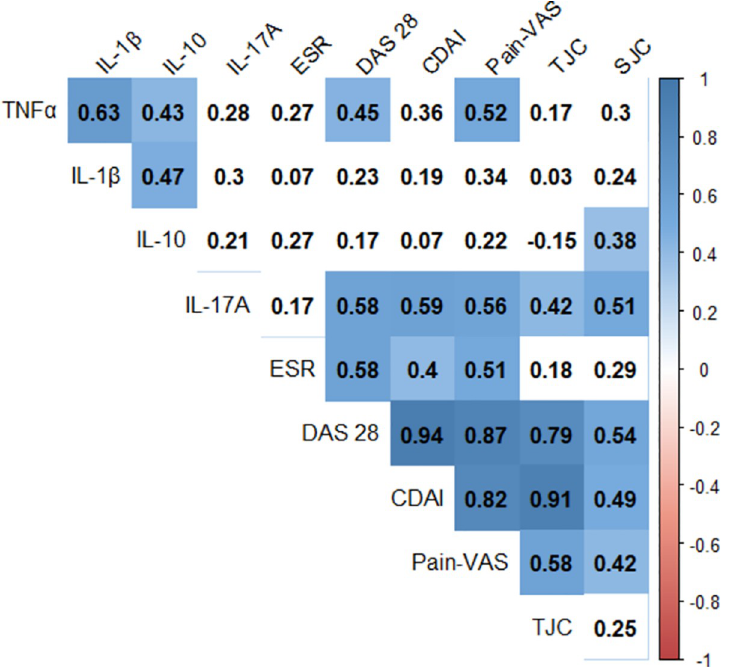
Fig 3. Correlogram illustrating the correlation coefficient between different measures of disease activity. The four cytokines tested along with the single and composite measures of disease activity have been included in the correlation matrix. The colour scale visualizes the strength and direction of the correlation. Numbers indicate the Spearman’s correlation coefficient ( ρ ) and only the numbers on blue background are statistically significant (p < 0.05). Statistical test- Spearman’s rank correlation coefficient ( ρ ). The strength of correlation ‘ ρ ’: 0.00–0.19 (very weak), 0.20–0.39 (weak), 0.40–0.59 (moderate), 0.60–0.79 (strong), 0.80–0.10 (very strong). ESR-erythrocyte sedimentation rate, TJC- tender joint count, SJC-swollen joint count, Pain-VAS- joint pain as measured by the visual analog scale, DAS 28- disease activity score 28, CDAI-clinical disease activity index.